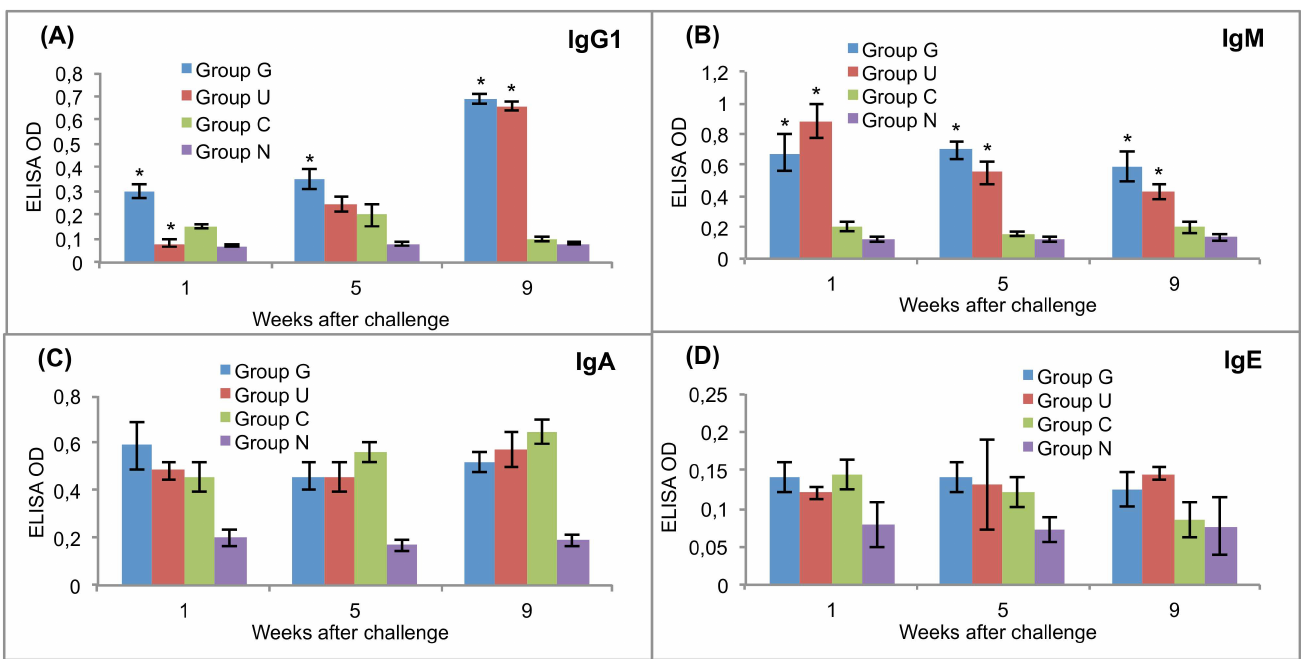
Fig 2. Post-challenge serum antibody isotype responses of vaccinated and control rats to recombinant cysteine proteinase. (A) IgG1. (B) IgM. (C) IgA. (D) IgE. Group G–Lyophilisedlettuce expressingthe mature CPFhW enzyme flankedby Gly-rich linkers; Group U–Lyophilised lettuce expressingthe mature CPFhW protein fused with ubiquitin;Group C–Lyophilised control lettuce; Group N–None.At each timepoint, four rats from each group were euthanised and dissected. * Indicatessignificantly increasednumbers of cells ( p < 0.05).Error bars indicatestandard deviation.